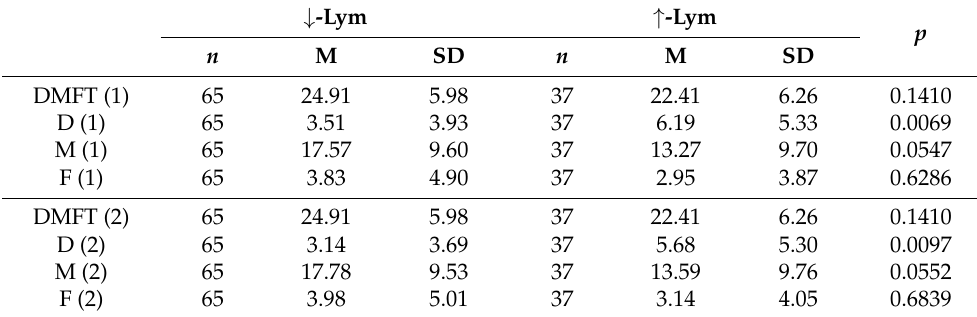
Table 5. Lymphocytes count change and DMFT index before (1) and after (2)